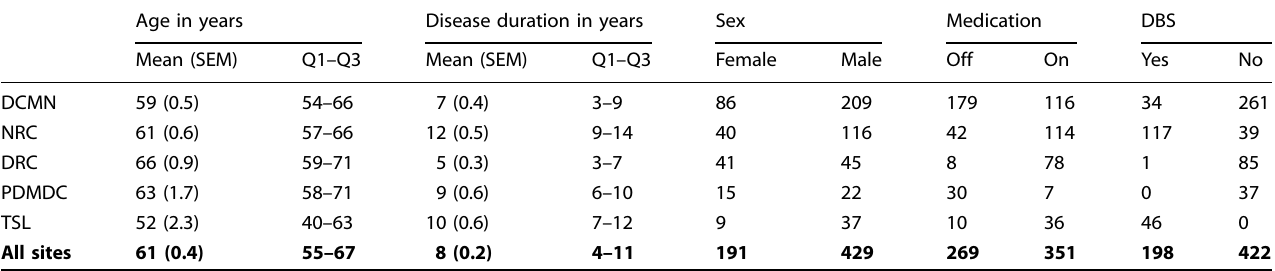
Table 2. Statistics summarising patient characteristics, for the 620 assessments where this additional information was available, broken down by clinical site.